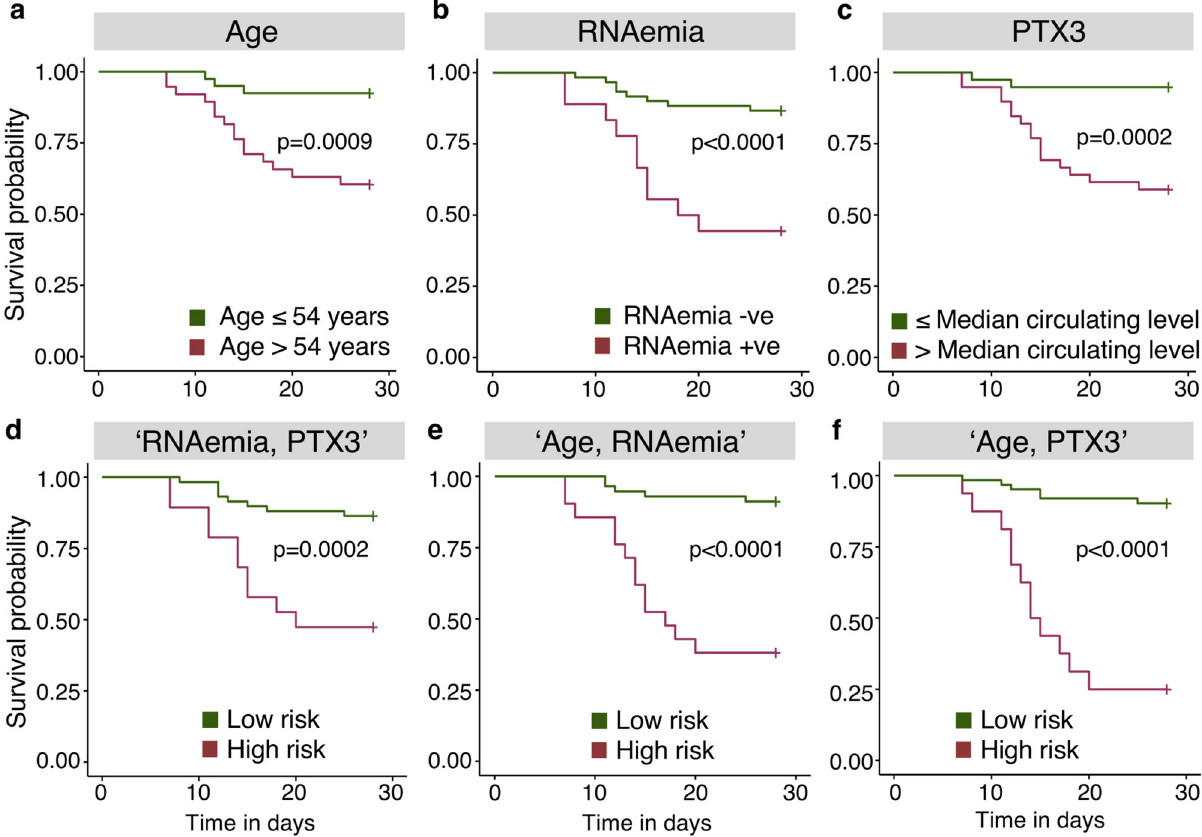
Fig. 5 SARS-CoV-2 mortality prediction using machine learning. a Kaplan – Meier plot for age (using the median age of 54 years). b Kaplan – Meier plot for SARS-CoV-2 RNAemia. As a single predictor, RNAemia provides the best strati fi cation for survival. c Kaplan – Meier plot for PTX3 using the median levels of serum or plasma. d – f Kaplan – Meier plots for “ RNAemia, PTX3 ” , “ Age, RNAemia ” , and “ Age, PTX3 ” combined using support vector machine with radial basis function kernel (SVM RBF), a non-linear machine learning model. The machine learning model selected binary combinations of “ Age, RNAemia ” and “ Age, PTX3 ” as the best predictors. Kaplan – Meier analysis is two-tailed. Nonsurvivors: n = 18; survivors: n =